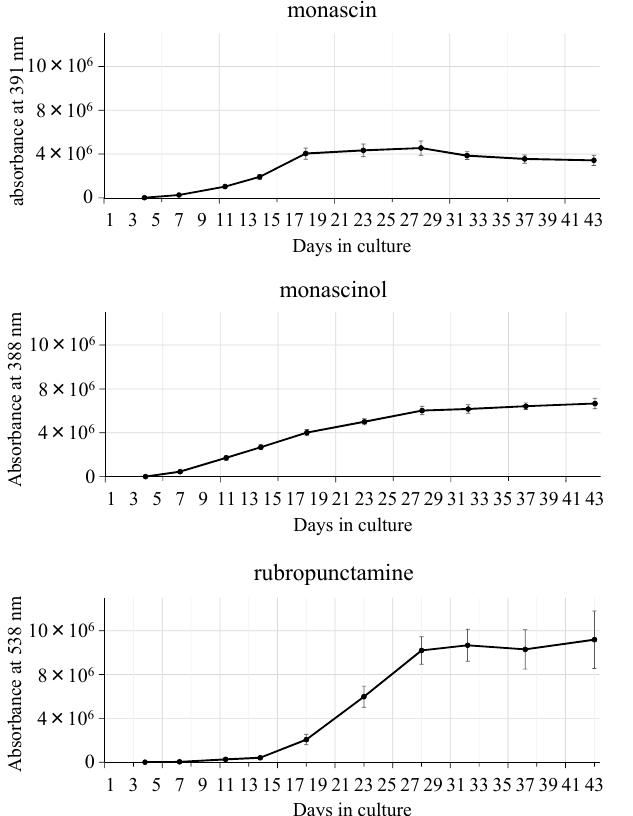
Figure 10. Time course change in the contents of 3 azaphilone pigments in red yeast rice during fermentation, quantified according to the reference method [30].